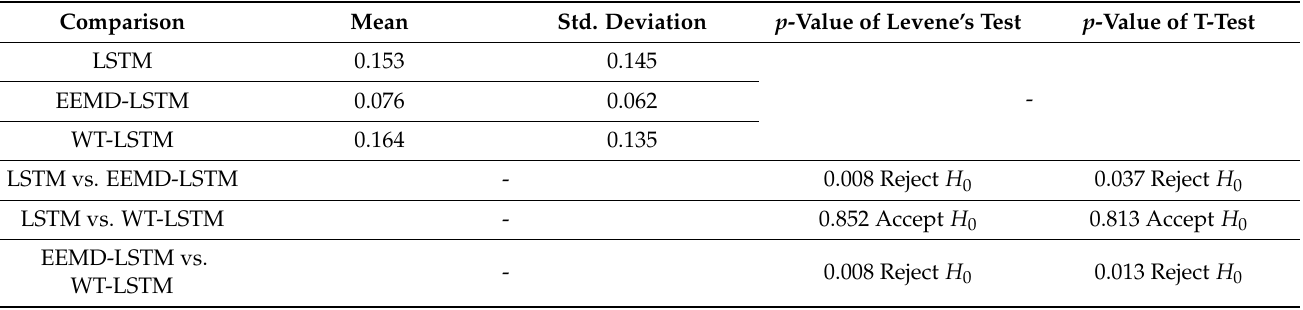
Table 17. Statistics’ test